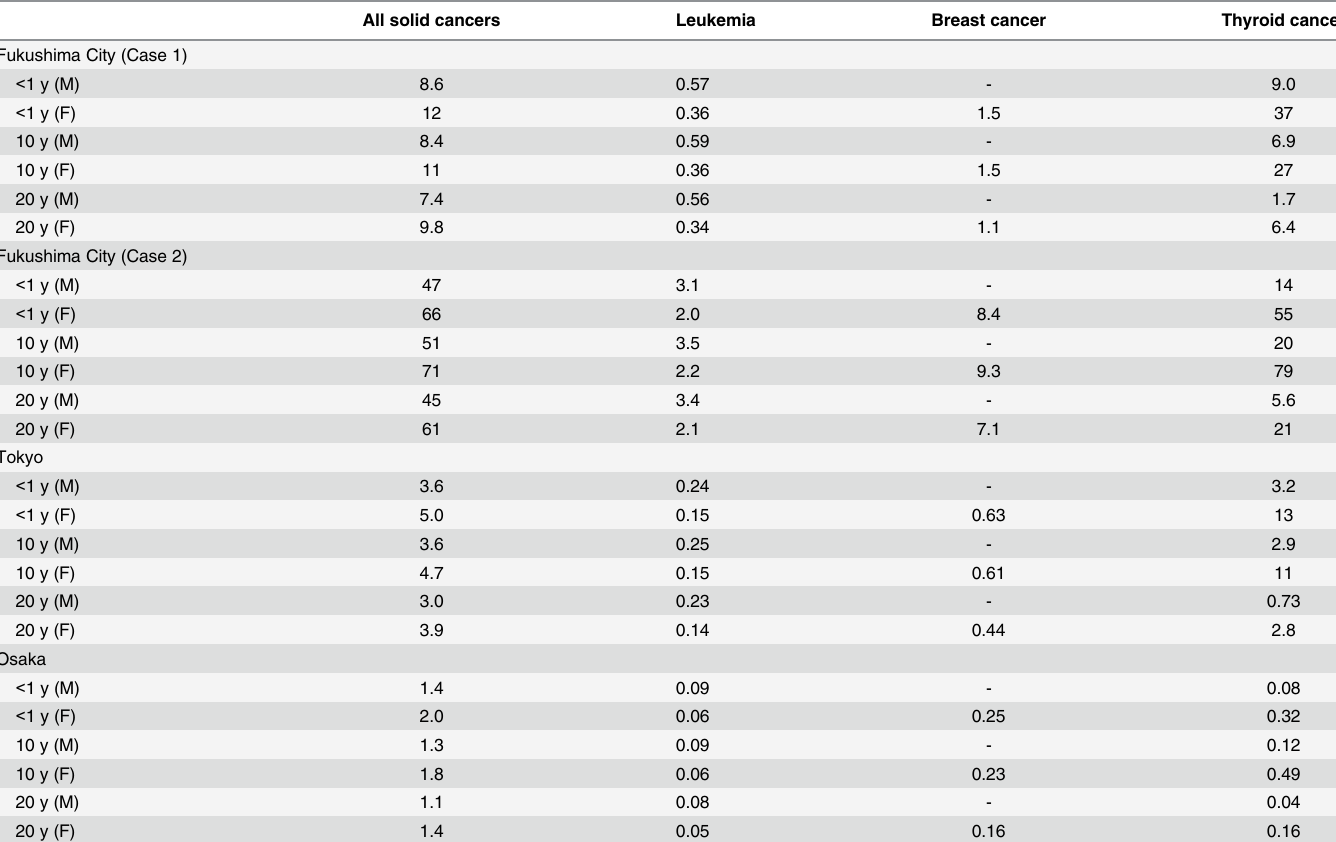
Table 3. LARs for all solid cancers, leukemia, breast cancer, and thyroid cancer (×10 − 6 ) due to ingestion.